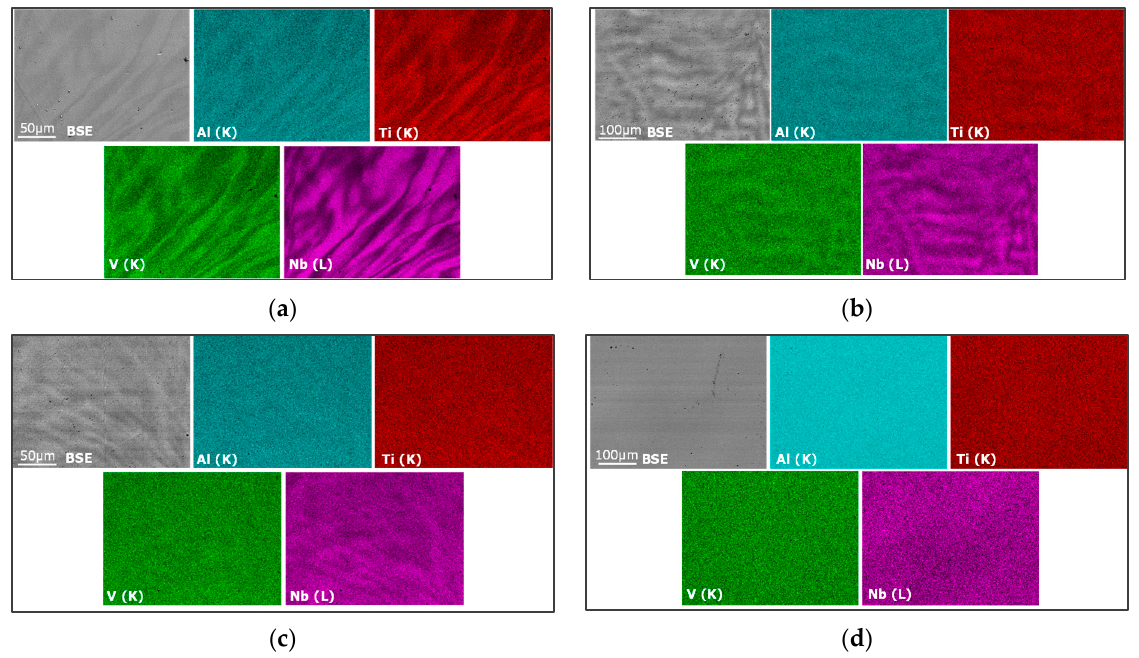
Figure 2. SEM-EDX chemical mapping of the as-cast ( a ) Al 0.05 (TiVNb) 0.95 , ( b ) Al 0.10 (TiVNb) 0.90 , ( c ) Al 0.175 (TiVNb) 0.825 , ( d ) Al 0.25 (TiVNb) 0.75 . Table 3. EDX chemical analysis of the Al x (TiVNb) 1-x as-cast alloys with x = 0.05, 0.10, 0.175, 0.25. Nominal Dendritic Composition Element (at. %) erage (at. %) Zone (at. %)